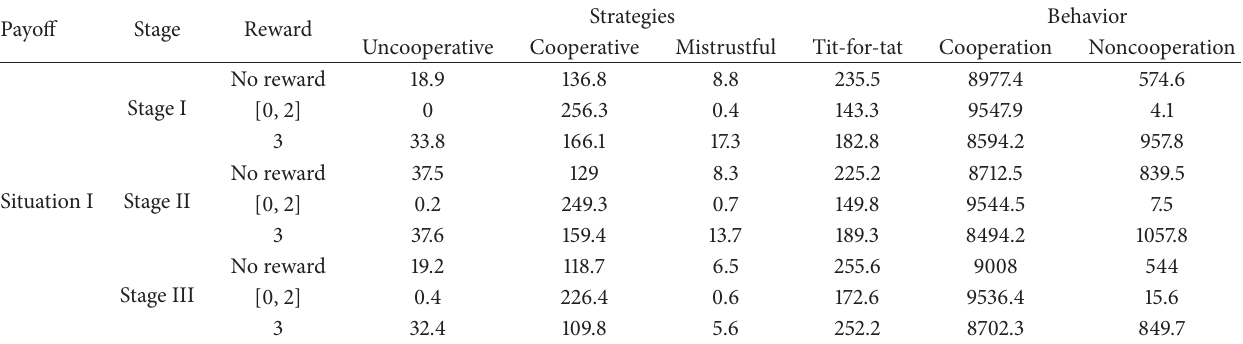
Table 4: Average frequencies of different strategy in Situation I of innovation with each incentive. Payoff